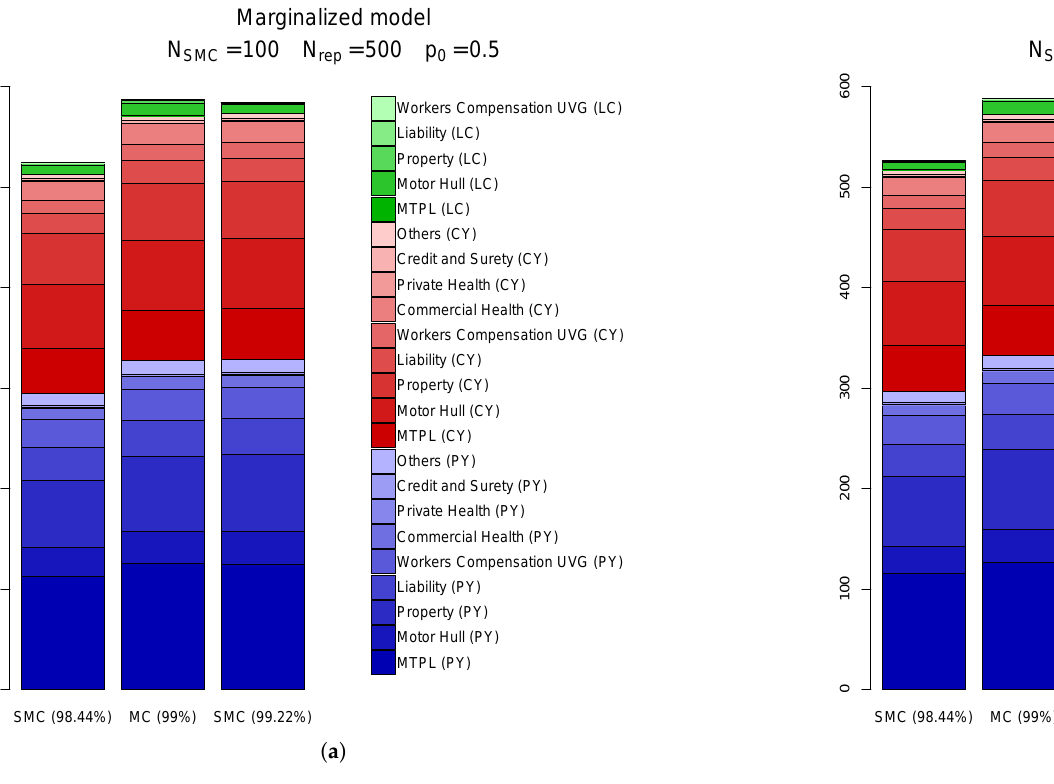
Figure 11. Comparison between the “true” allocations (calculated via a large Monte Carlo procedure) and the SMC sampler solution for the ( a ) marginalized and ( b ) conditional